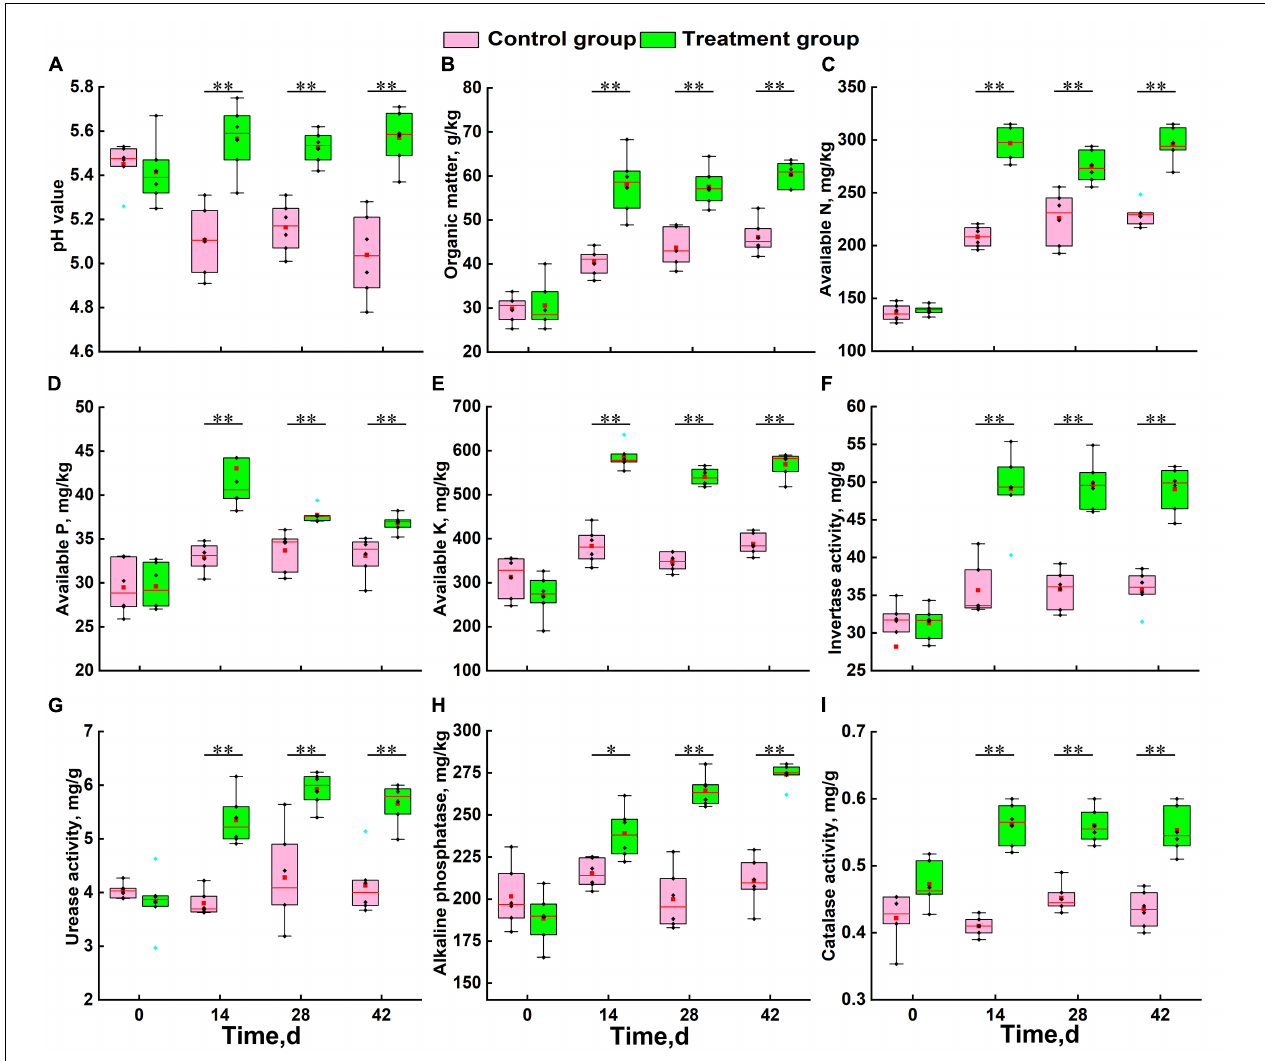
FIGURE 1 | Effect of S. alfalfae XY25 T on physicochemical factors of soil. (A) pH value; (B) organic matter; (C) available nitrogen; (D) available phosphorus; (E) available potassium; (F) invertase; (G) urease; (H) alkaline phosphatase; (I) catalase. n = 6; different letters for the same item indicate significant differences at P < 0.05 level. The error bars represent the standard deviation (SD). The horizontal bars within boxes represent medians. The tops and bottoms of boxes represent the 75th and 25th percentiles, respectively. The upper and lower whiskers extend to data no more than 1.5 × the interquartile range from the upper edge and lower edge of the box,